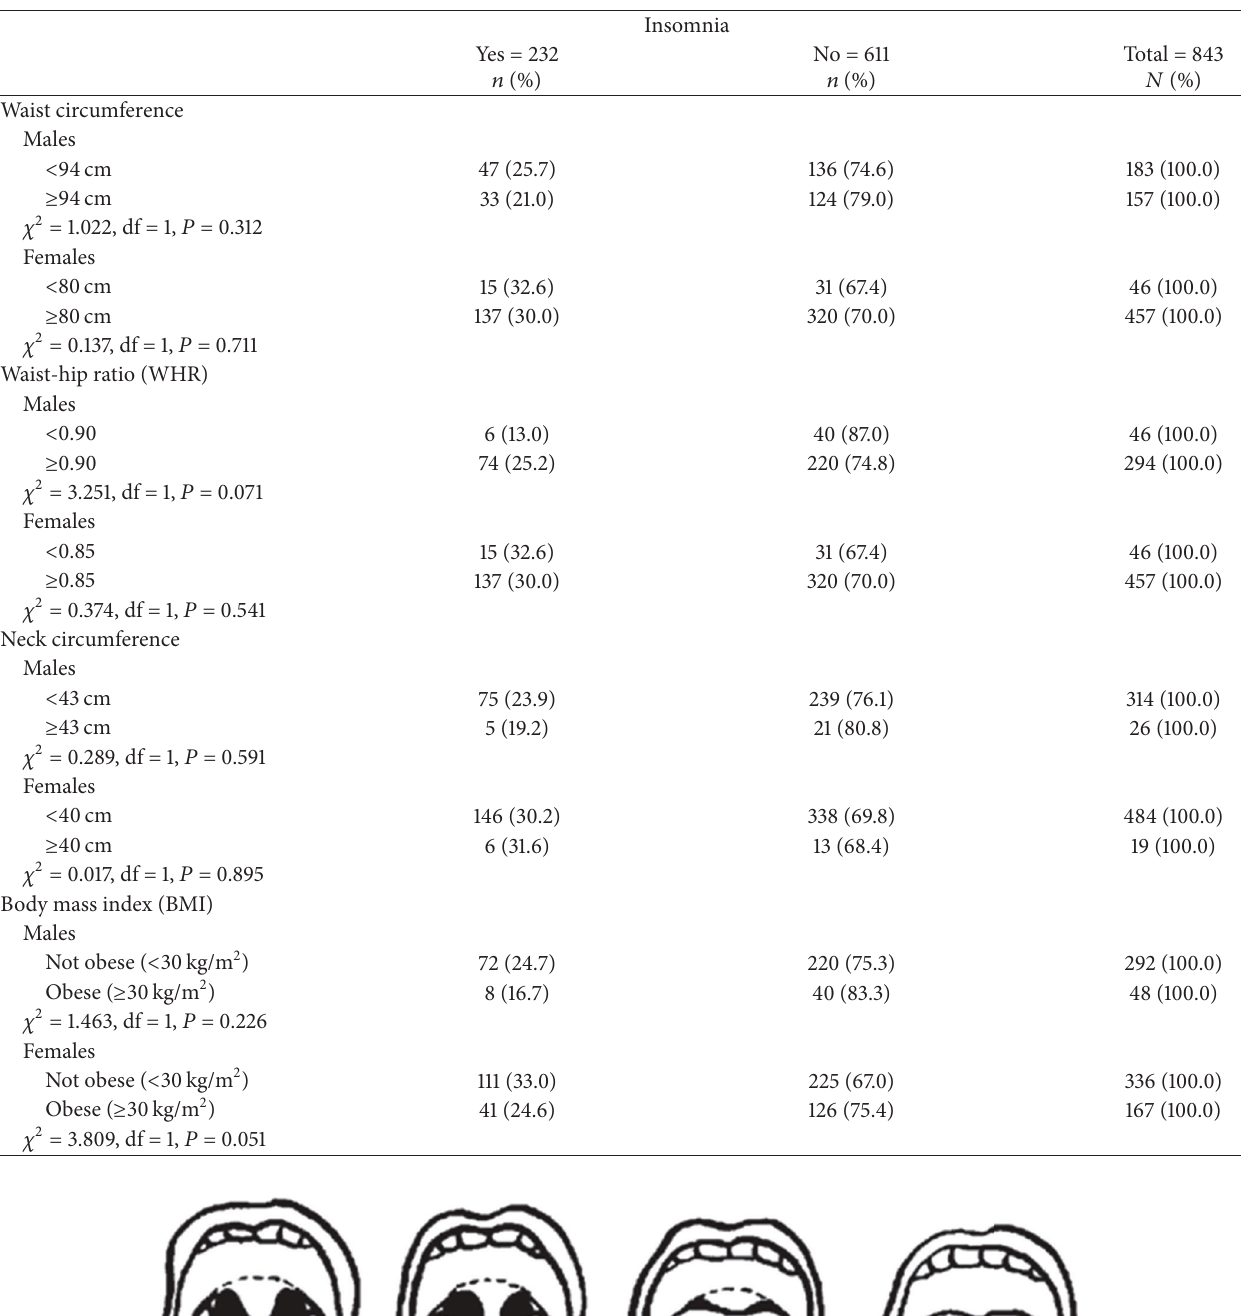
Table 5: Anthropometric measurements by prevalence of insomnia.